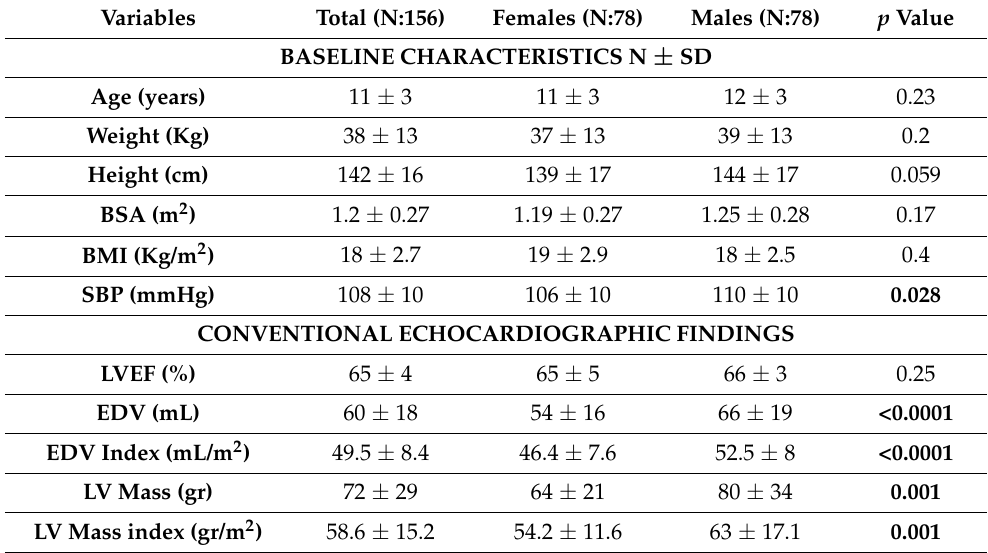
Table 1. The demographic, anthropometric and conventional echocardiographic parameters catego- rized by